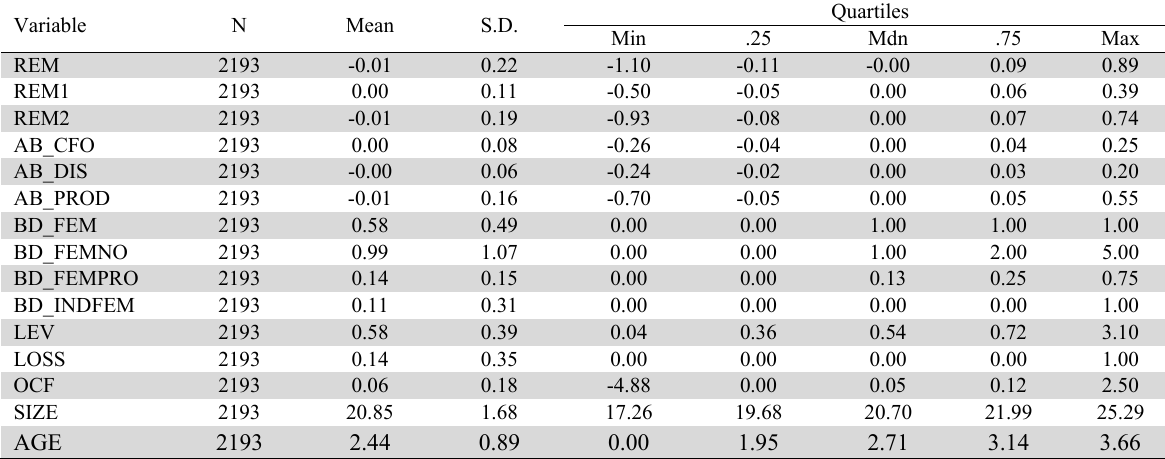
The results of some basic statistics